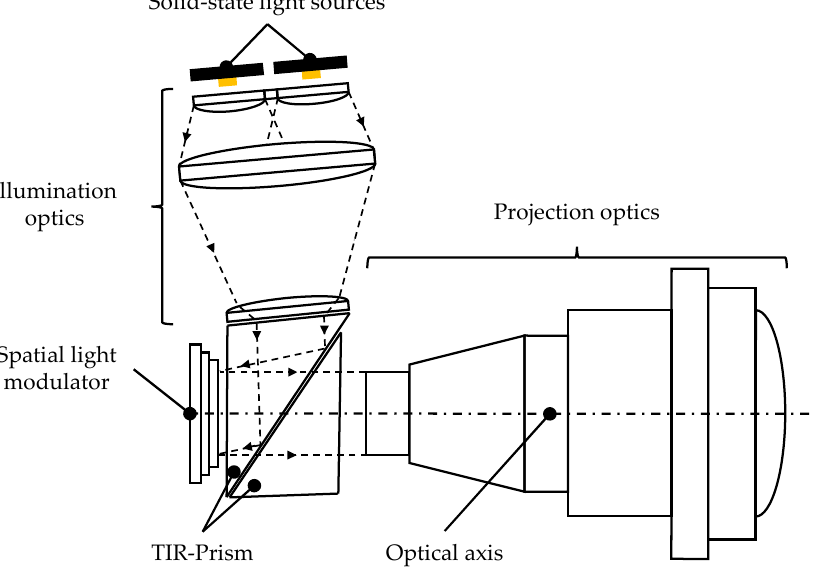
Figure 2. Concept of a high-resolution headlamp according to